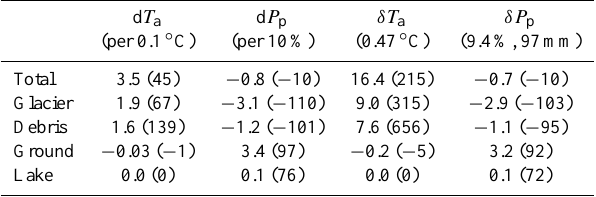
Table 6. Sensitivities of annual runoff (millionm 3 ) and runoff depth (mm) (parentheses) associated with changes in air temperature (d T a , 0.1 ◦ C) and precipitation (d P p , 10% or 103mm) for the Tsho Rolpa Glacial Lake–Trambau Glacier basin. Also shown are sensitivities associated with interannual variability ( δ , standard deviation) of air temperature and precipitation calculated for the period 1979–2007 (28 years). d T a d P